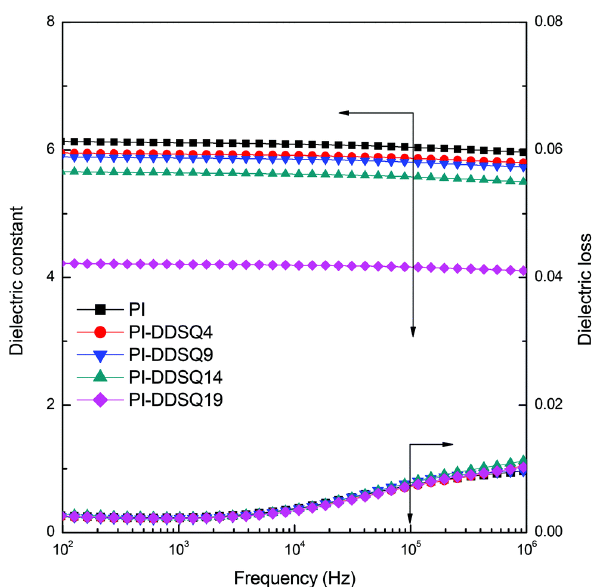
Figure 13. Plots of dielectric constant of organic/inorganic PIs with DDSQ in the main chain [82]. Reproduced with permission from the Royal Society of Chemistry.